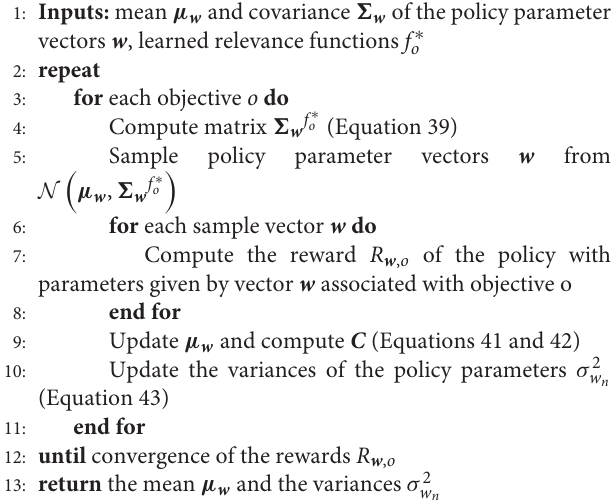
Algorithm 5 Policy Optimization using Relevance Functions